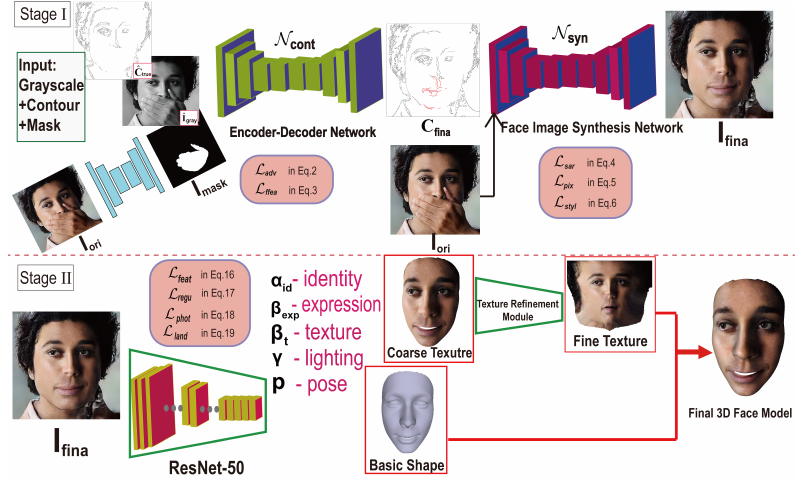
Figure 1. Method overview. See related sections for